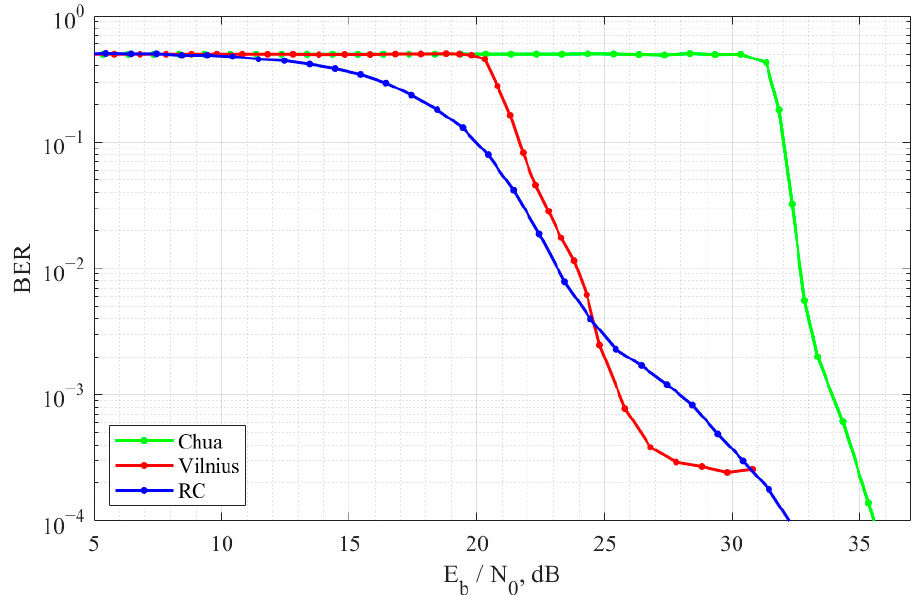
Figure 12. BER curves of FM-CSK communication system based on Chua’s, Vilnius, and RC chaos oscillators in an AWGN channel.